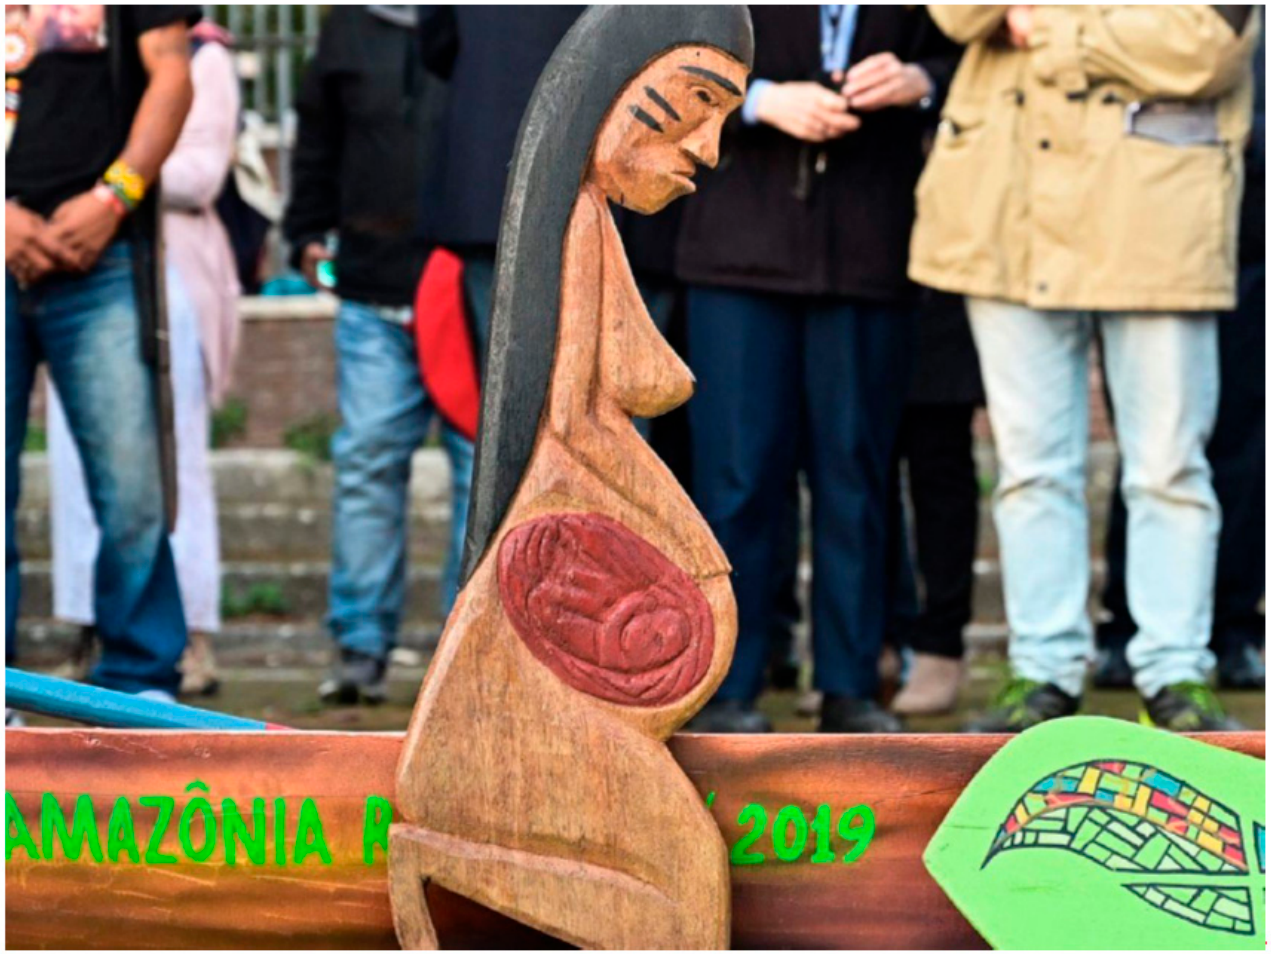
Figure 1. One of the statues representing ‘Mother Earth’ at the opening ceremony of the Amazonian Synod. Source: Vincenzo Pinto/AFP. Synod. Source: Vincenzo